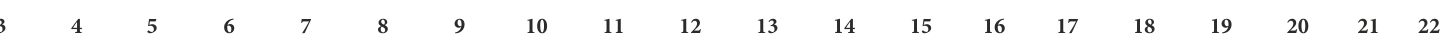
TABLE 6 Correlation matrix of subjective well-being and its influencing